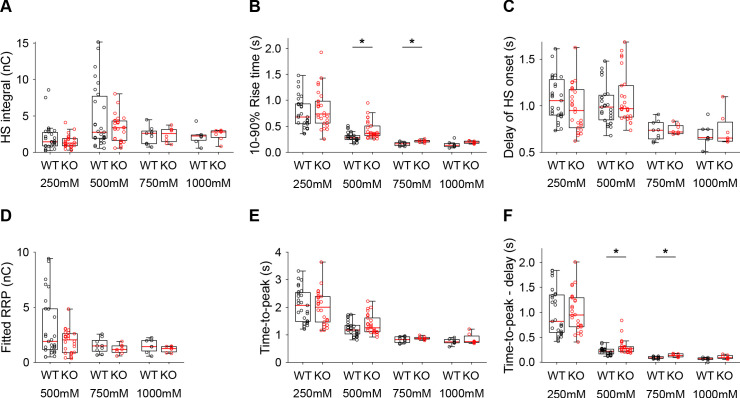
Additional HS parameters from WT and Syt1 KO neurons.(A) Integral of current from HS-induced release at different concentrations. (B) 10–90% rise time of peak HS-induced current. (C) Time delay after application of HS before onset of release. (D) Model-derived RRP values from depleting HS stimulations. (E) Time from start of HS application till peak HS-induced current. (F) Time from start of HS application till peak HS-induced current, corrected for the delay in release onset after HS application. All panels comparing WT and Syt1 KO (*p<0.05, Wilcoxon rank sum test).
Figure 1—figure supplement 2—source data 1.Statistics overview.